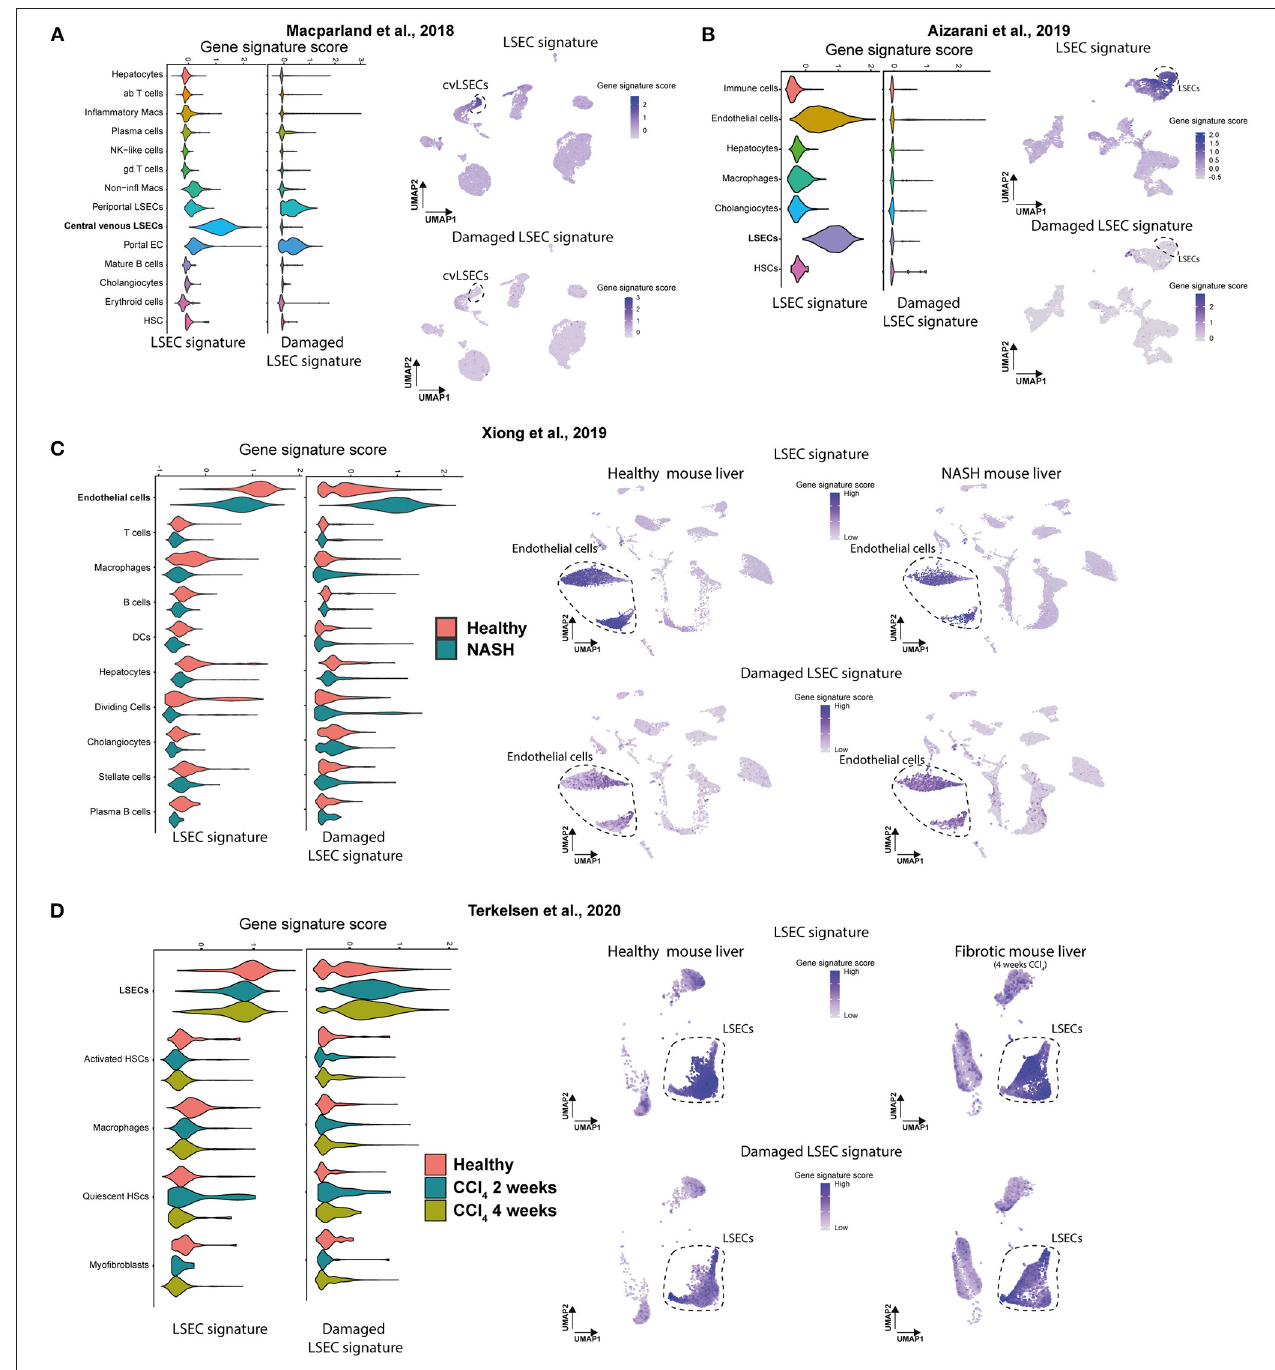
FIGURE 6 | Gene signature scores of LSEC signatures in scRNAseq data of human and mouse livers. (A,B) Gene set enrichment score (Violin plot left) of both signatures and UMAP plot of scRNAseq data of healthy human livers with gene set enrichment score of both signatures in purple (right). Results were obtained with the use of the dataset of Macparland et al. (24) and Aizarani et al. (21). (C,D) Gene set enrichment score (Violin plot, left) of both signatures and UMAP plot of scRNAseq data of (NASH and fibrotic) mouse livers with gene set enrichment score of both signatures in purple (right). Results were obtained with the use of the dataset of Xiong et al. (26) and Terkelsen et al.